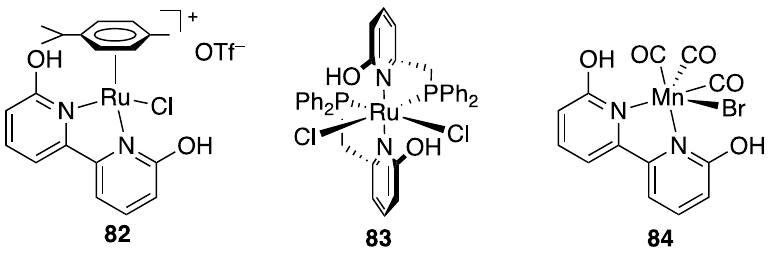
Figure 5. Ru and Mn complexes bearing hydroxypyridine-based ligands for the catalytic hydrogenation of CO 2 .